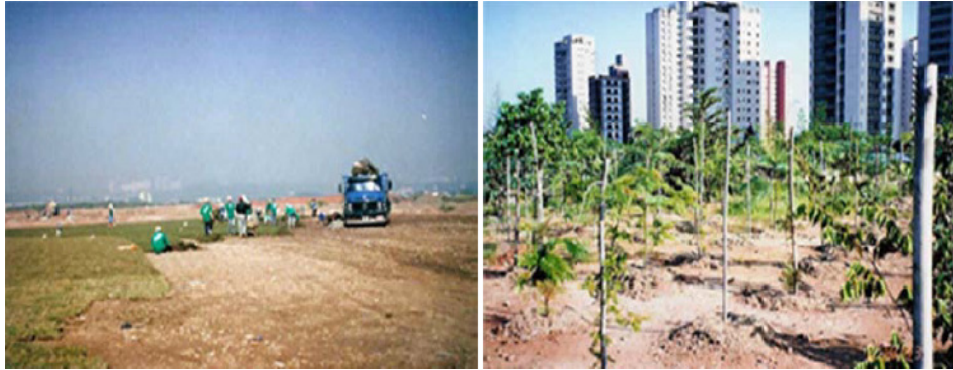
Figure 7. Building of Villa-Lobos State Park in 1989